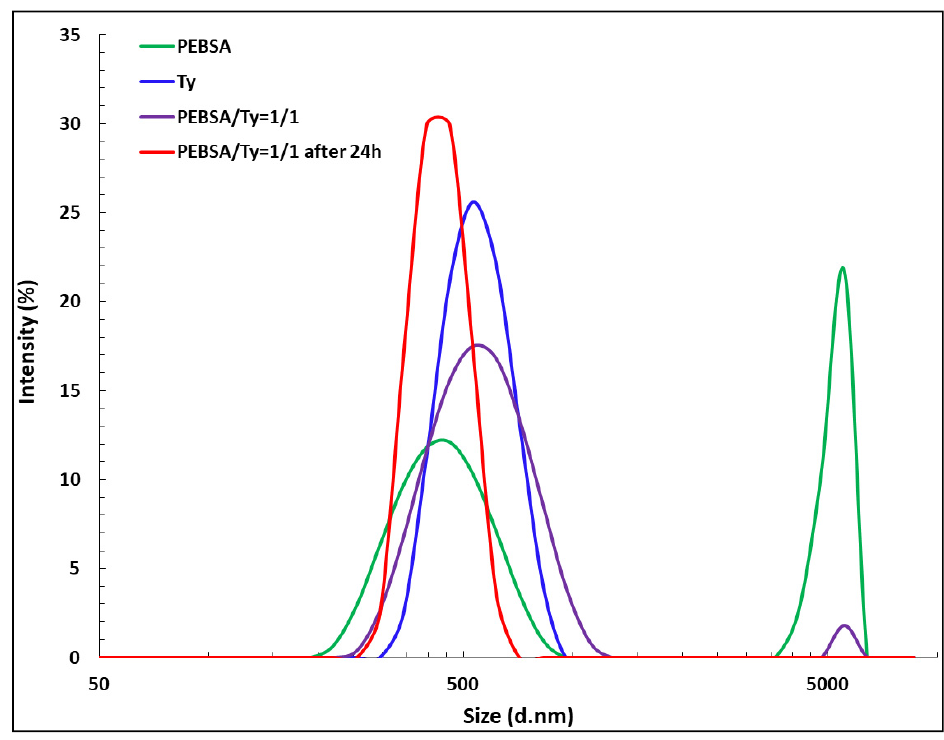
Figure 11. Size distribution of PEBSA copolymer, PEBSA_Ty complex and Thymol.